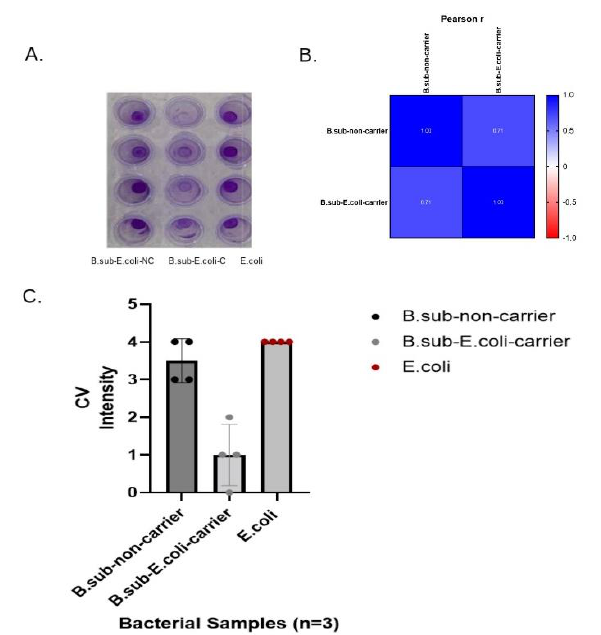
Figure 3 : Biofilm Assay for E. Coli and AB. Subtilis Carrier A. E. Coli had a total score of 16 with an average CV intensity of 4 (Avg=4, SD=0). B. The Pearson r analysis shows coefficients of 1 between the non-carriers while there was a coefficient of 1 in the co-culture samples of carriers. There was a 0.71 coefficient between the noncarriers and the carriers, showing a decrease in correlations between each sample. C. B.subtilis-Carriers combined with E. Coli averaged a score of 1 CV intensity and a total score of 4 (Avg.=1 SD=0.8). E. Coli, grown with WT B. subtilis, averaged a 3.5 CV score and had a total score of 14 (Avg=3.5, SD=0.58).